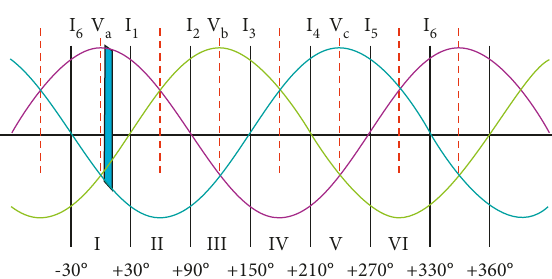
Figure 2: Division of input phase voltage sectors.